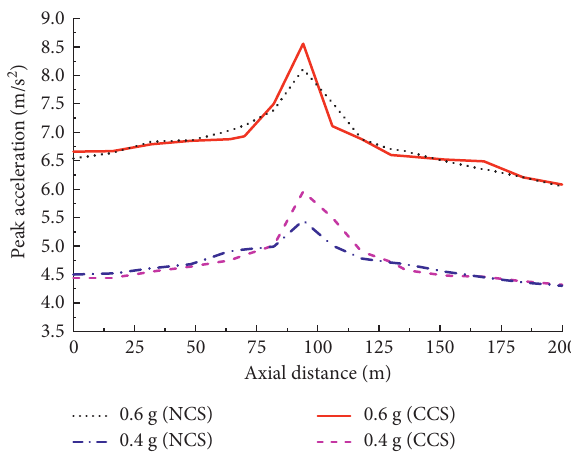
Figure 14: Changes in the peak acceleration of the composite structure along the axial of the